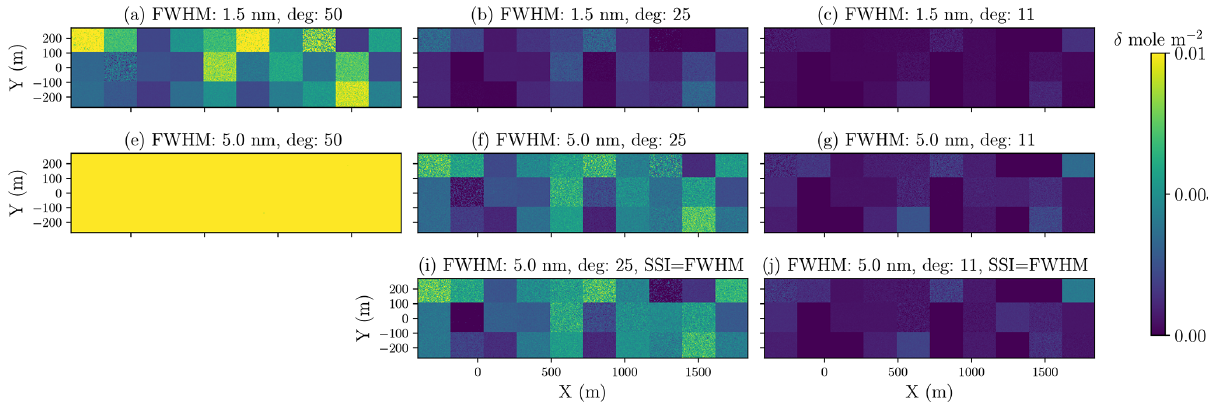
Figure 14. The increase in precision errors when the polynomial degrees of 50, 25, and 11 are used, as compared to the polynomial degree of 5 case. The increase is computed for a given FWHM and SSI, according to each